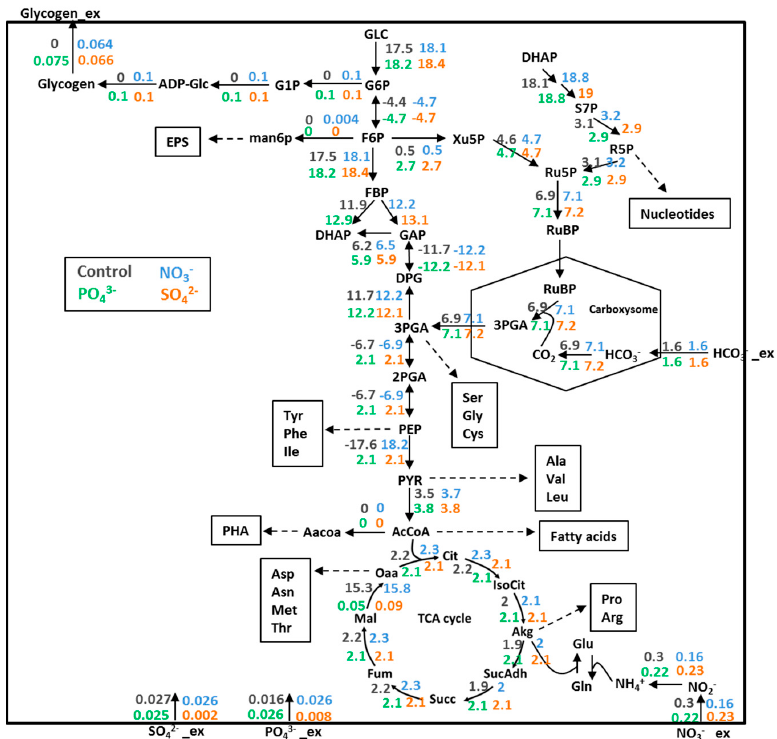
Figure 4. Illustrative fluxes in central metabolic predicted by geometric FBA for each growth condition: Control (black), NO 3 − -limited (NO 3 − , blue), PO 43 − -limited (PO 43 − , green) and SO 42 − -limited (SO 42 − , orange). The diagram included key reactions including the glycolysis, the carbon fixation through CO 2 -concentrating mechanism, the nonoxidative pentose phosphate pathway, the TCA cycle, and biosynthetic pathways of glycogen. Single and double-headed arrows indicate reactions assumed to be irreversible and reversible, respectively. Numbers labeled at the corresponding arrows show flux values in